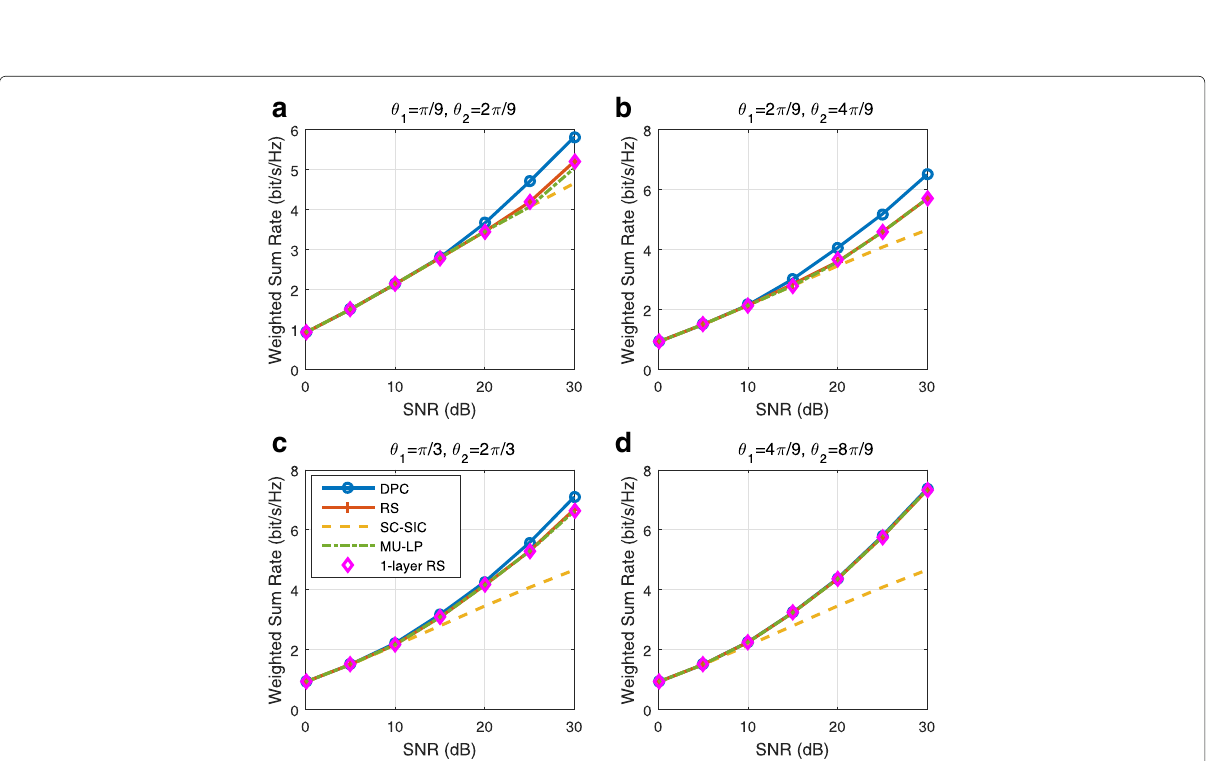
Fig.37 WeightedsumrateversusSNRcomparisonofdifferentstrategiesforunderloadedthree-userdeploymentwithperfectCSIT, γ 1 = 0.3, γ 2 =